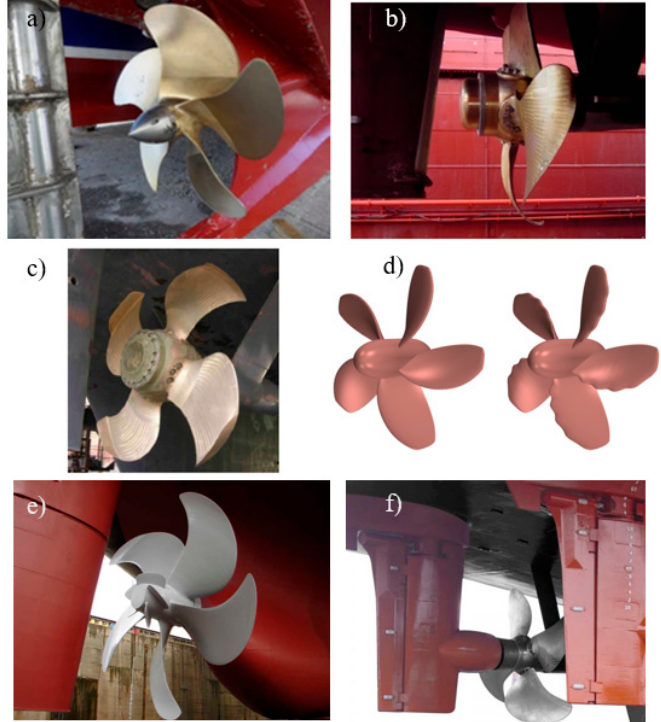
Figure 9. Existing and emerging propeller and hub modification ESDs: ( a ) NPT propeller reproduced with permission (copyright University of Strathclyde); ( b ) Kappel Propeller reproduced from Chekab et al. [107] (CC-BY); ( c ) CLT propeller reproduced from Chekab et al. [107] (CC-BY), published by Science and Education Publishing; ( d ) TAPs; ( e ) PBCFs adapted from Korrigan/Wikipedia https://commons.wikimedia.org/wiki/File:Sokoto_propeller.jpg (CC BY) accessed (5 January 2022); ( f ) Rudder Bulb (reproduced with permission; copyright Becker Marine Systems).